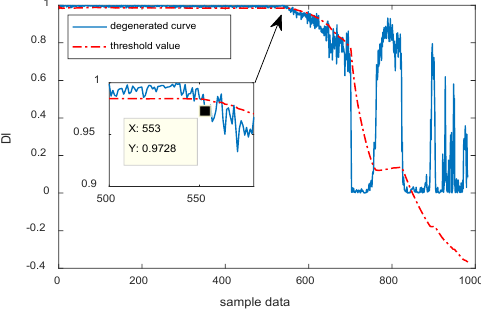
Figure 19. Degradation index based on LLE-FCM.